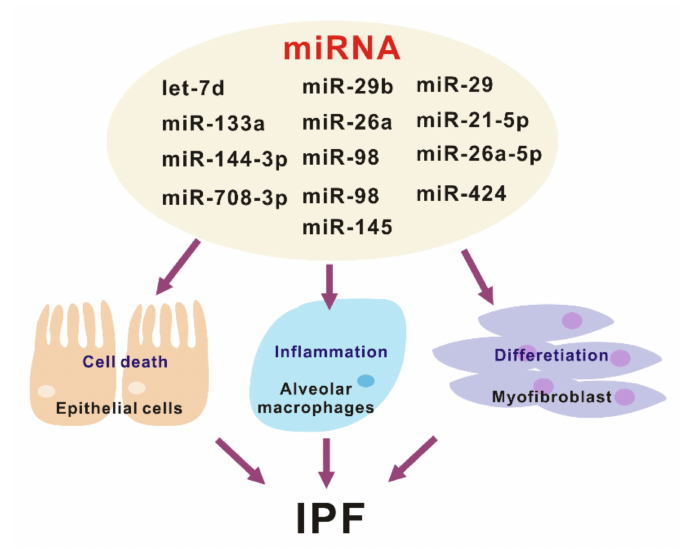
Figure 2. The various roles of miRNA in the pathogenesis of idiopathic pulmonary fibrosis